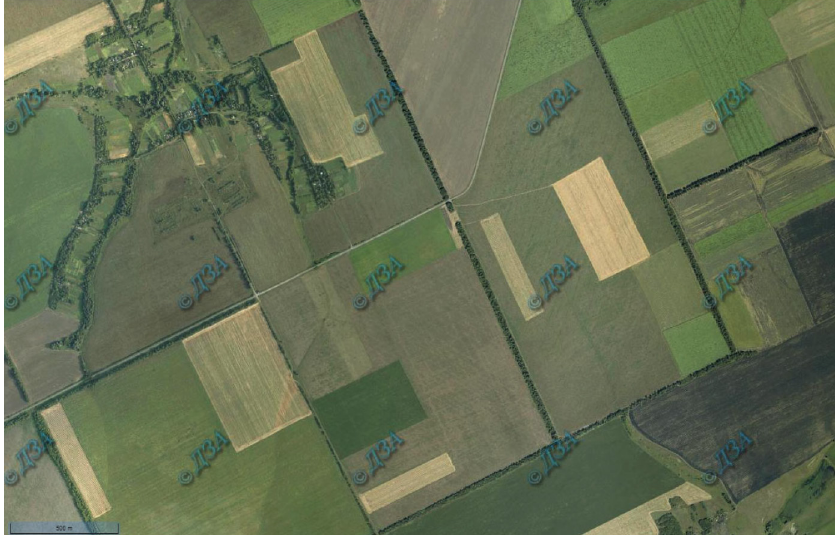
Figure 1. Typical land plots placement within a land mass. Public Cadastral Map of